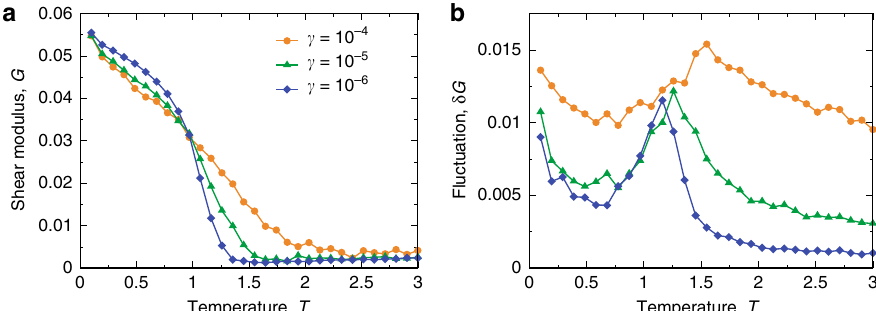
Fig. 5 Temperature dependence of shear modulus and its fl uctuation. Temperature dependence of the shear modulus G ( a ) and its fl uctuation δ G ( b ) for different cooling rates γ . The γ -dependent nonequilibrium glass transition temperature is signalled by the onset of the growth of G and a peak of δ G . Such a γ -dependent (laboratory) glass transition accompanied by the emergence of solidity is consistent with the characterization of spatial stress correlations shown in Fig.